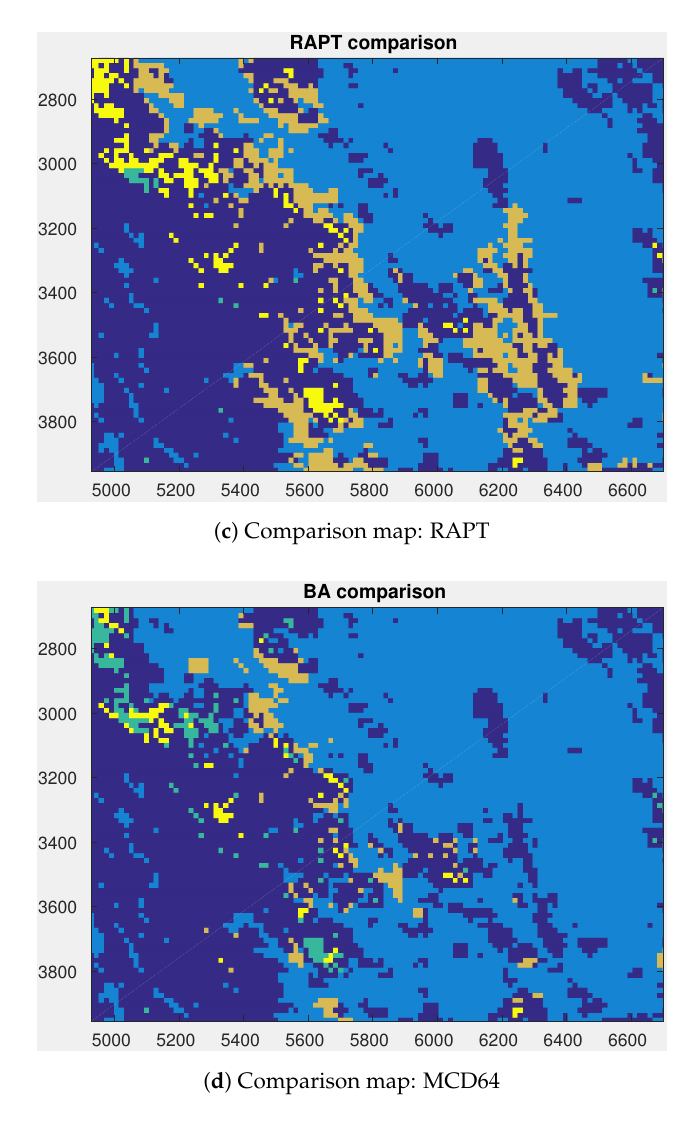
Figure 5. Figure shows an example of errors of commission based on Landsat-based validation maps. The top row shows before and after false color composites (using bands 7,4,2) of a region with detected burned area (WRS path-232, WRS row-070, MODIS tile name-h11v10, year 2010). The bottom row shows the burned area detected by RAPT and MCD64 relative to Landsat-based ground truth generated using the BAMS scheme. Each comparative image is color coded as yellow for true positives, orange for false positives, green for false negatives and light blue for true negatives. Masked regions (due to detectable cloud cover or non-forest landcovers) are colored dark blue in the comparative images. Note that the region shown has 1000 × 1600 Landsat